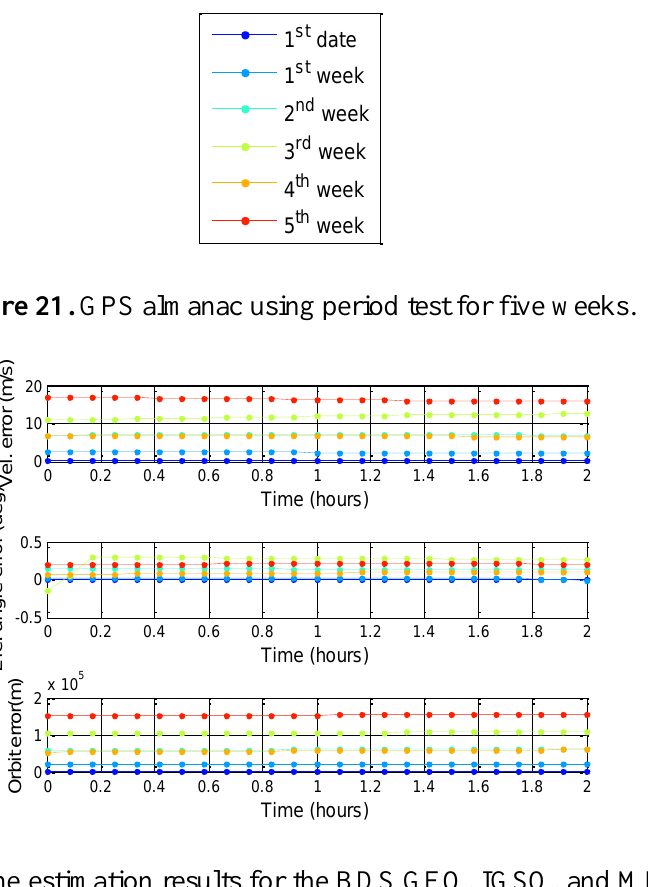
Figure 20. BDS DQA1: The legend of the Figure 21 to 24.